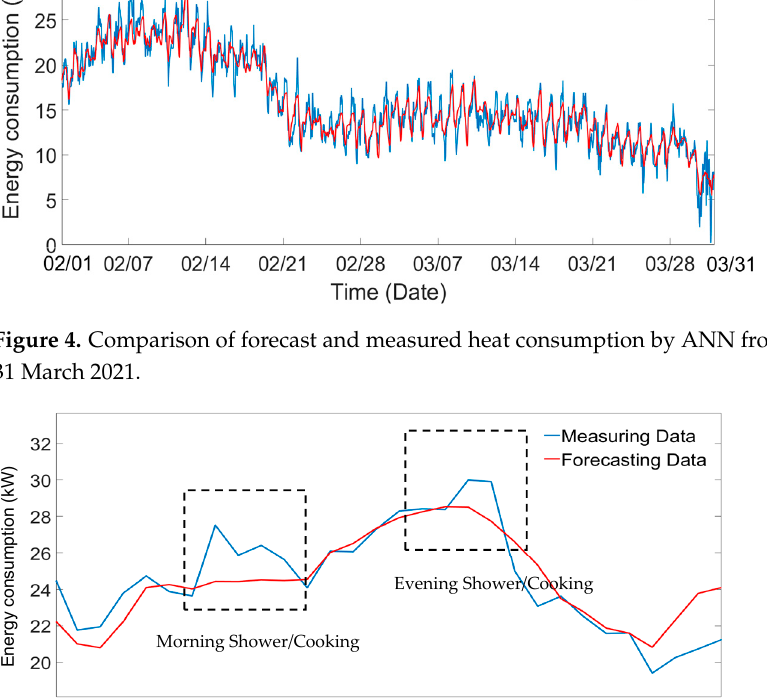
Figure 6. Distribution of MBE and MAE in the forecasting period.